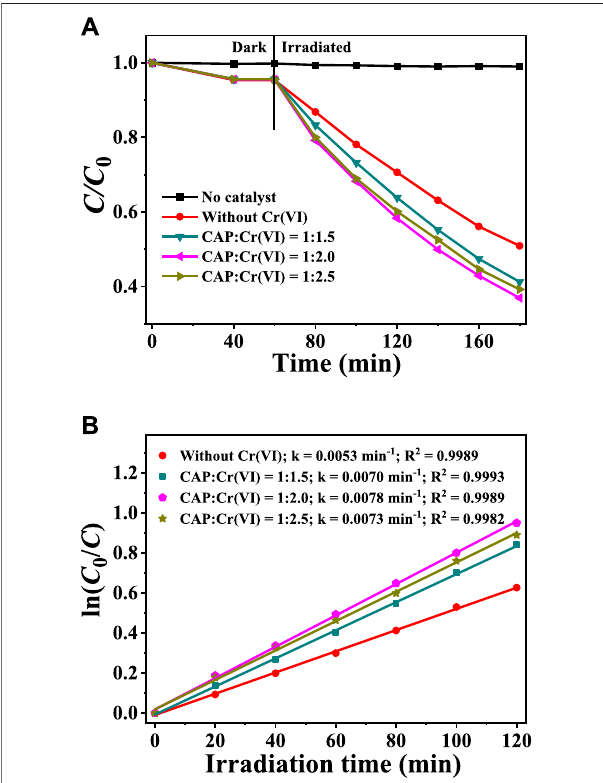
FIGURE 8 | (A) Adsorption and photocatalytic degradation of CAP over CuInS 2 undervisibleirradiationinthemixedsolutionwithdifferentweightratios of Cr(VI) and CAP (B) Corresponding kinetics plots for the photocatalytic CAP degradation reactions in (A) . ([CAP] = 10 mg/L, [catalyst] = 0.2 g/L; pH = 3.0).